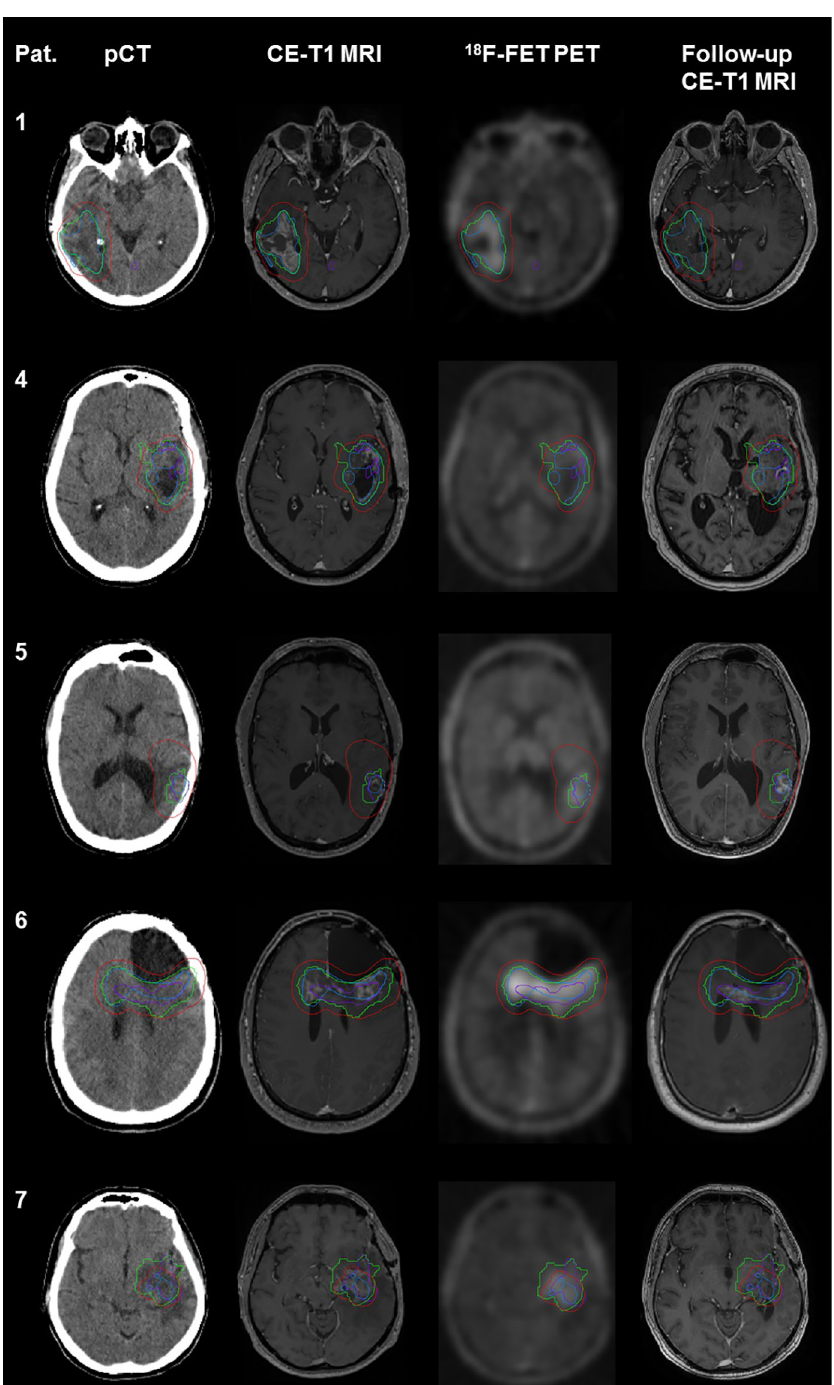
Fig 1. Treatment plan and pattern of recurrence. Original MRI based GTVs in blue, PET-MR GTVs in green, CTVs resembling original PTVs minus 3 mm in red and recurrent tumour volumes in follow-up MRI in purple for all patients with available follow-up MRI at recurrence. In patients 1, 4 and 7 no PET information was contained in the original target volumes.